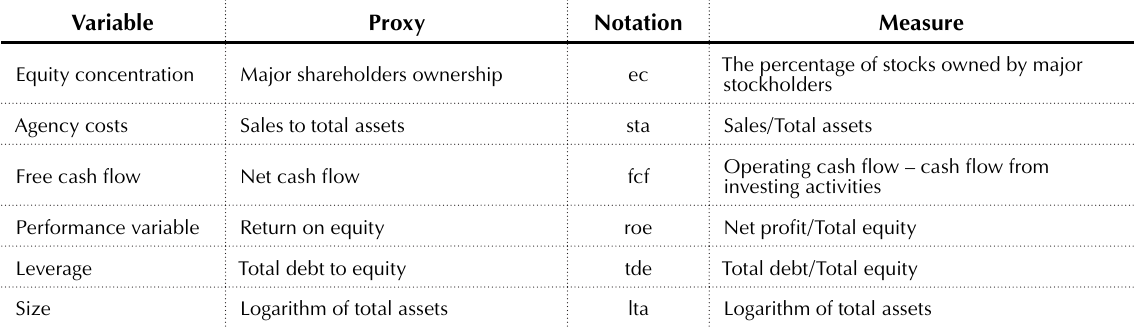
Table 1. Variables and